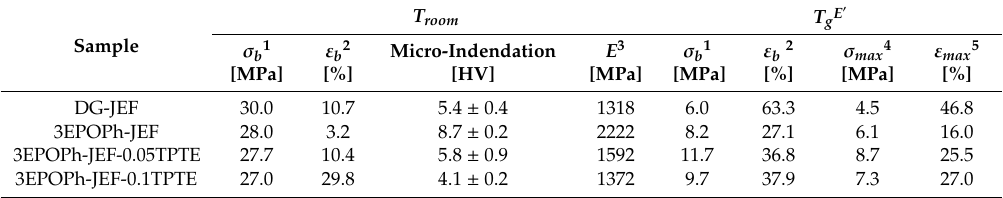
Table 5. Mechanical properties of the materials studied at T room and T gE the mean value of three di ff erent samples tested is shown. Coe ffi cients of variations are less than 7% for stress and strain results, and less than 5% for the Young’s